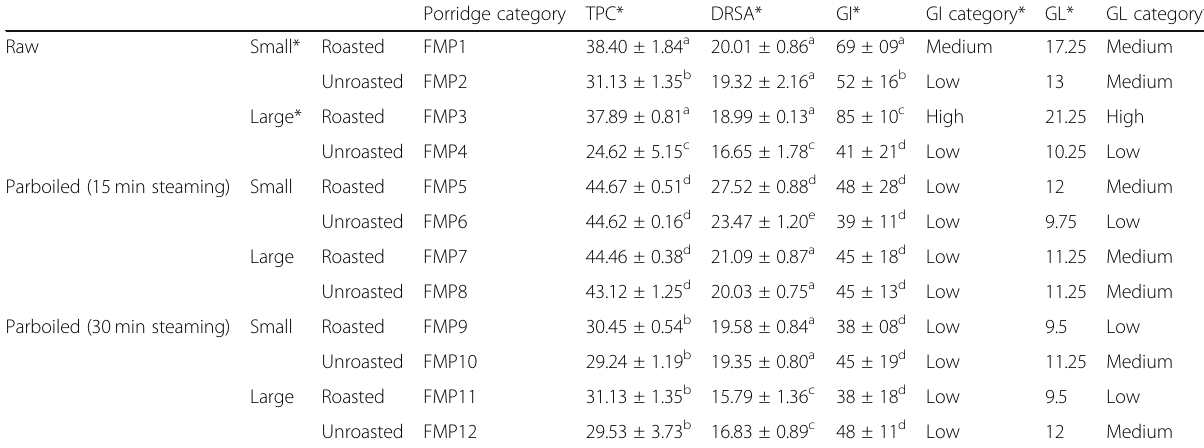
Table 2 Phenolic content, antioxidant activities and glycemic response of